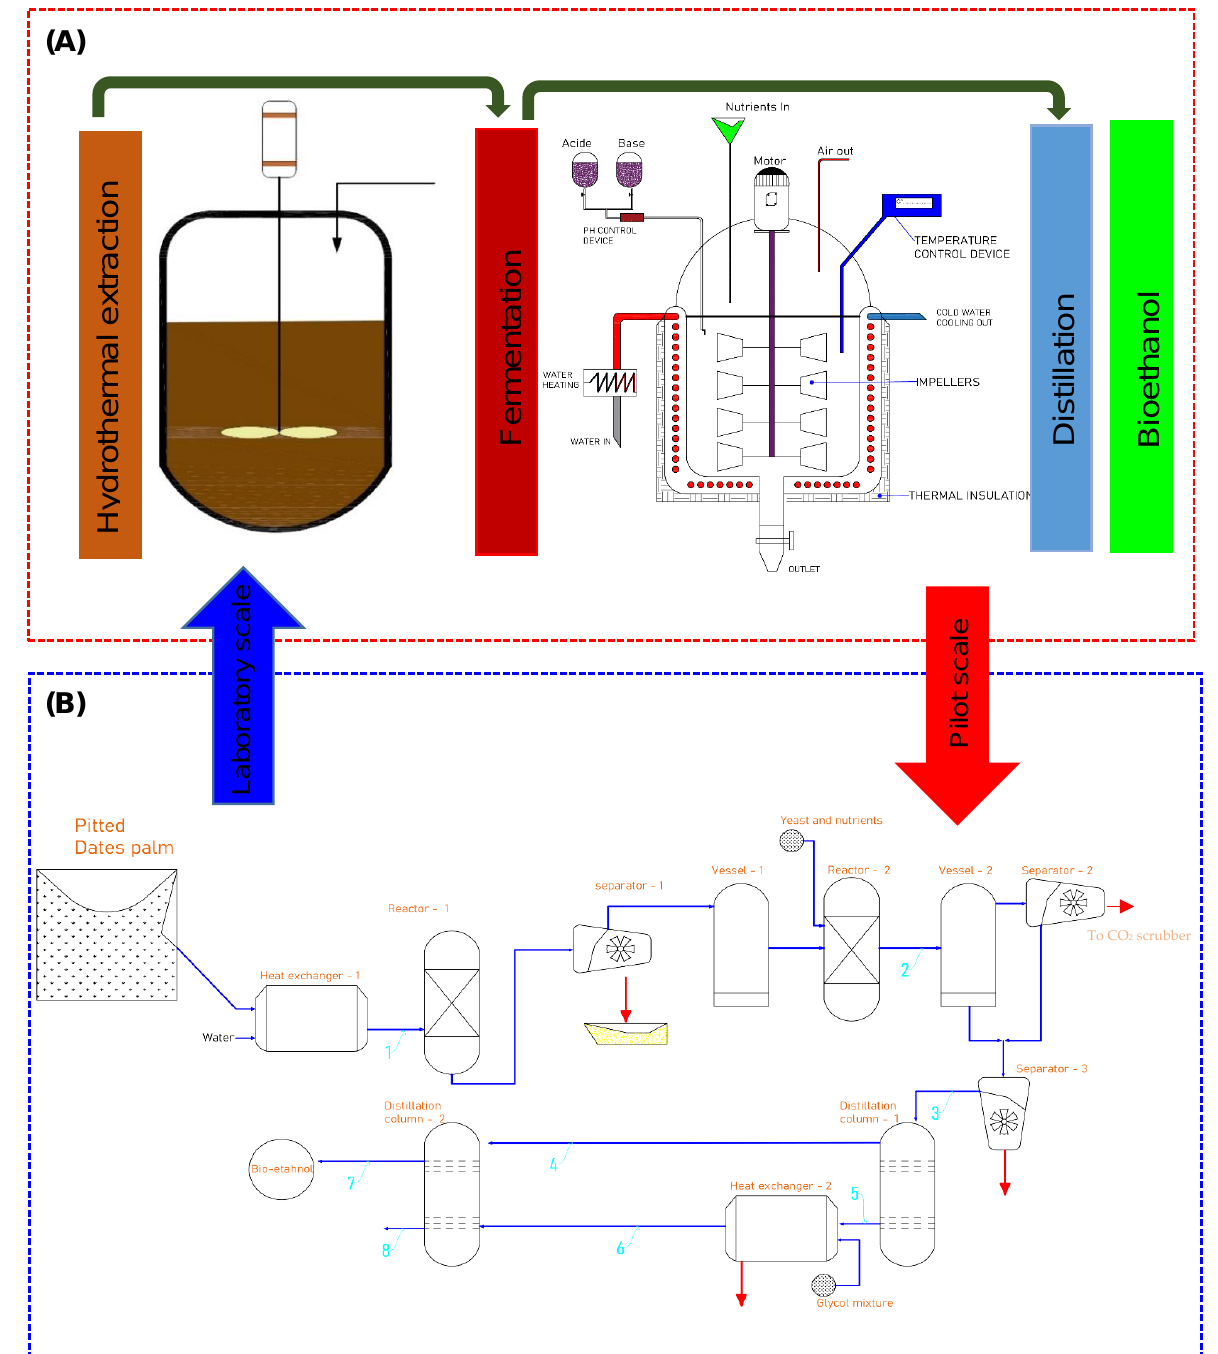
Figure 9. Schematic representation of bioethanol production processes: ( A ) lab-scale and ( B ) scale production design of bioethanol produced from palm dates.